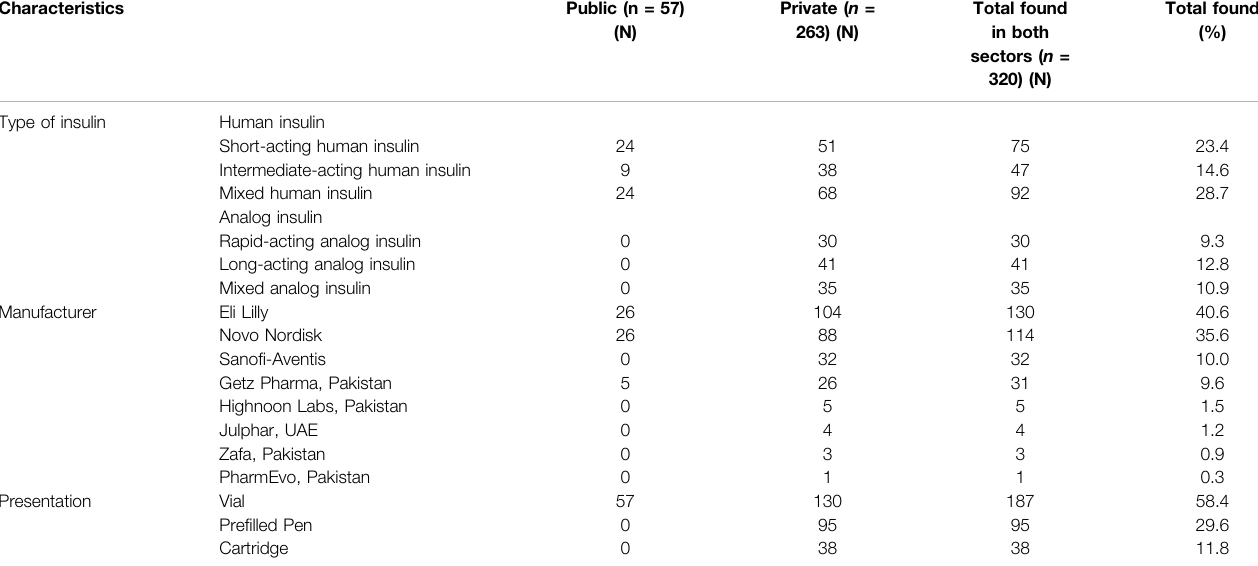
TABLE 1 | Number of insulin products in the public and private sectors by the type of insulin, manufacturer, and presentation. Prices, Availability, and Affordability survey, Pakistan, 2019.